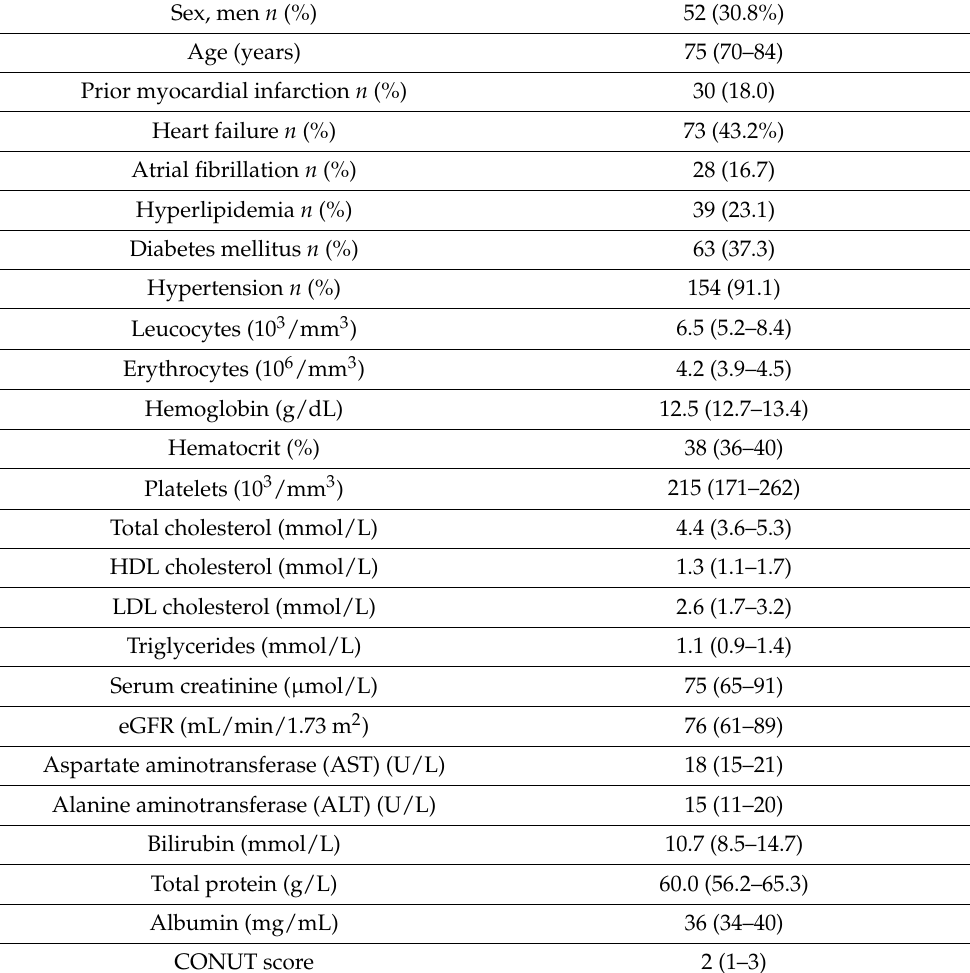
Figure 2. ( A ) Discordance between classification of weight status categories by BAI (BMI reference); ( B ) discordance between classification of weight status categories by BMI (BAI reference). Table 2. Baseline clinical and laboratory